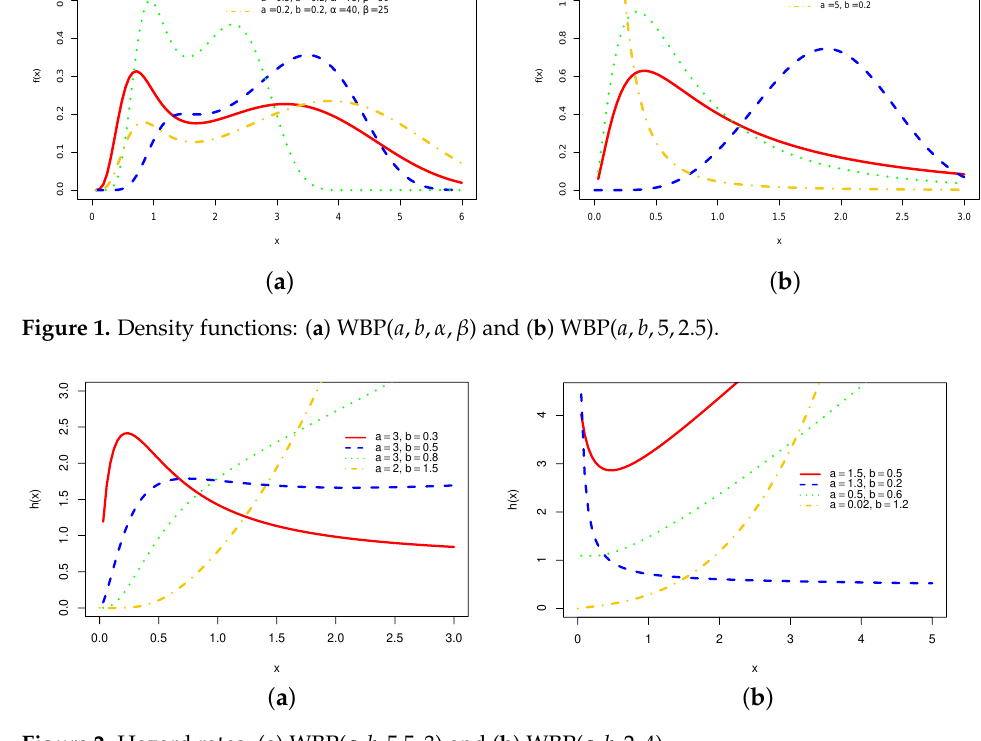
Figure 2. Hazard rates: ( a ) WBP( a , b ,5.5,3) and ( b ) WBP( a , b